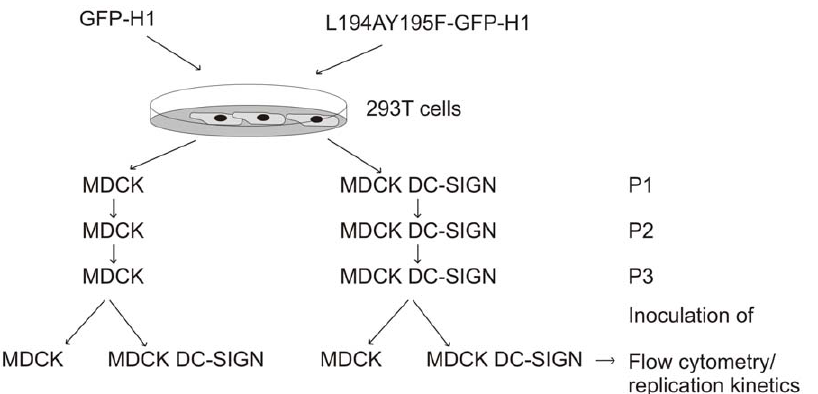
Figure 1. Schematic representation of the passage history and infection experiments with influenza viruses GFP-H1 and L194AY195F-GFP-H1.